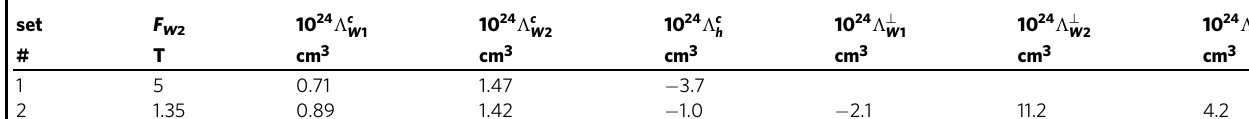
Table 2 The values of Λ c i and Λ ? i obtained from the c -axis and a -axis magnetostrictions, respectively. set